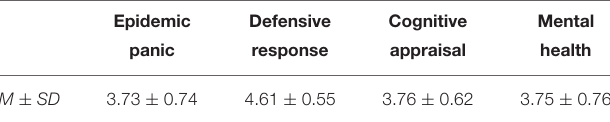
TABLE 1 | Stress response and mental health of college students when facing COVID-19.